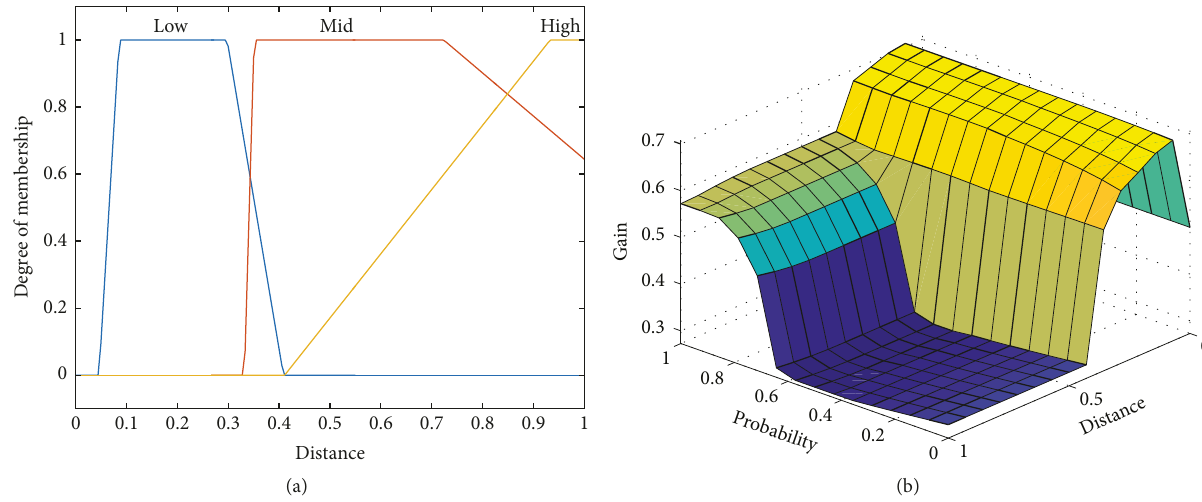
Figure 6: Membership function of input distance (a) and fuzzy output surface (b).